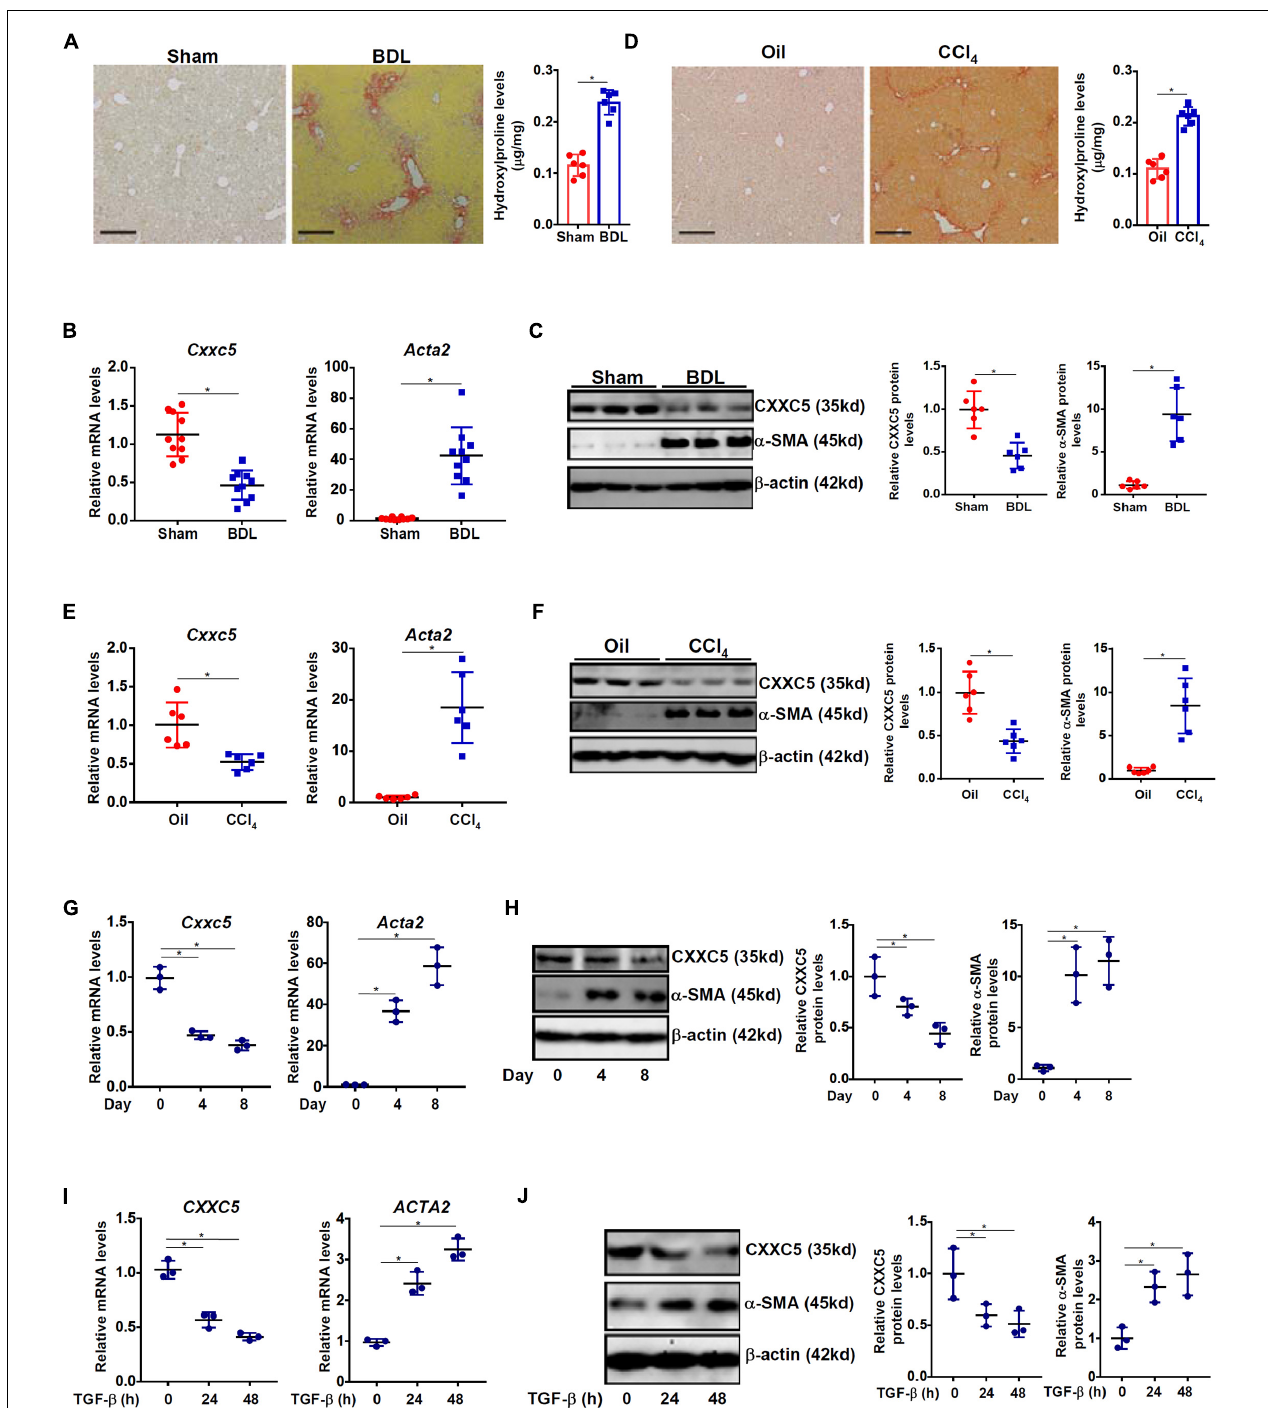
FIGURE 1 | Down-regulation of CXXC5 expression parallels hepatic stellate cell activation. (A–C) C57/B6 mice were subjected to the BDL or the sham procedure for 2 weeks as described in section “Materials and Methods.” (A) Liver fibrosis was confirmed by picrosirius red staining and hydroxylproline quantification. Primary hepatic stellate cells were isolated and CXXC5 expression levels were examined by qPCR (B) and Western (C) . (D–F) C57/B6 mice were injected with or without CCl 4 for 4 weeks as described in section “Materials and Methods.” (D) Liver fibrosis was confirmed by picrosirius red staining and hydroxylproline quantification. Primary hepatic stellate cells were isolated and CXXC5 expression levels were examined by qPCR (E) and Western (F) . N = 6–10 mice for each group. (G,H) Primary hepatic stellate cells were isolated from C57/B6 mice and allowed to undergo spontaneous activation in culture. CXXC5 expression levels were examined by qPCR and Western. (I,J) LX-2 cells were treated with or without TGF- β 1 (2 ng/ml). The cells were harvested at indicated time points and CXXC5 expression levels were examined by qPCR and Western. All experiments were repeated three times and one representative experiment is shown. * p < 0.05.